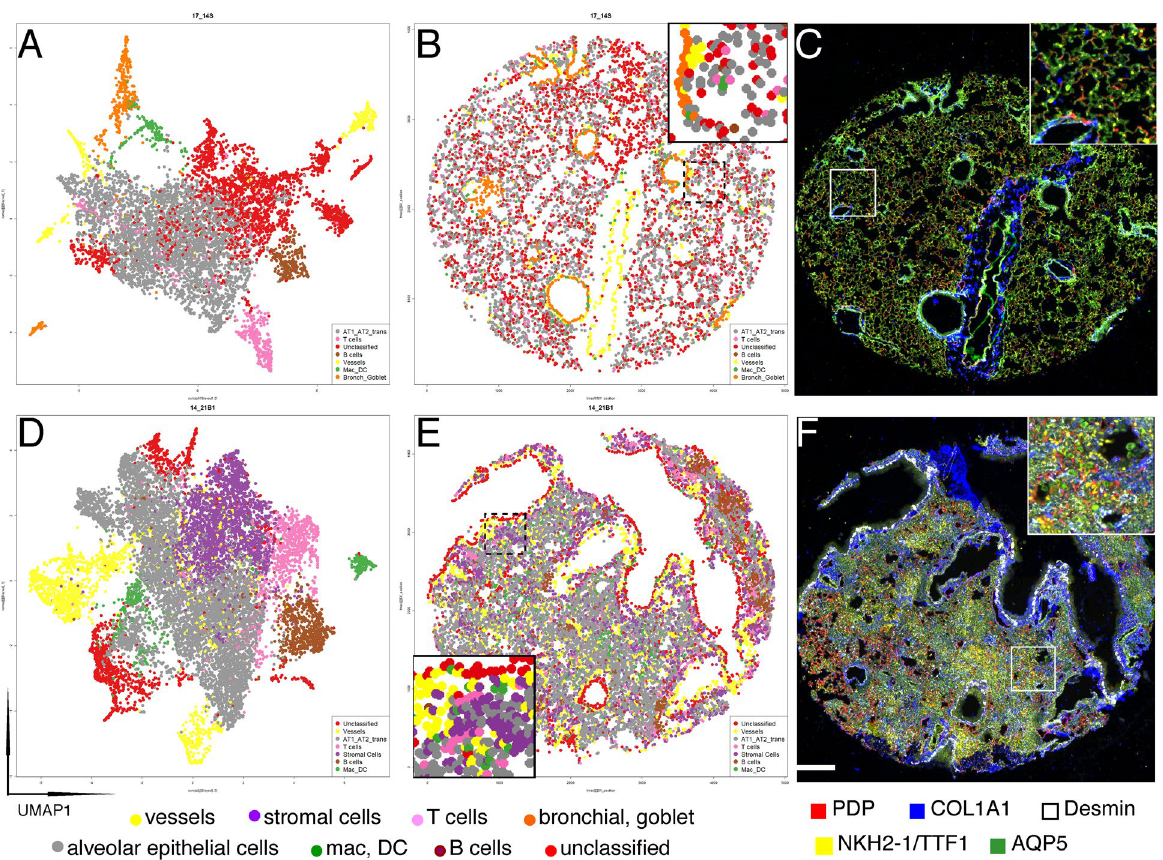
Figure 4. Spatial distribution of cell types. UMAP plots, spatial distribution of phenogroups and immunofluorescence images for representative untreated ( A – C ) and day 21 lungs ( D – F ). UMAP plots ( A , D ) are colored with the cell classification color (bottom legend). The same color-coded groups are plotted on the respective TMA core spatial coordinates ( B , E ). A detail is shown in the insets. Note in E a fibroblastic focus next to a bronchial lining population (red) and vessels. On the right five representative markers (color legend at the bottom) are shown in the whole core or in a high-magnification field (inset) ( C , F ). Scale bar 100